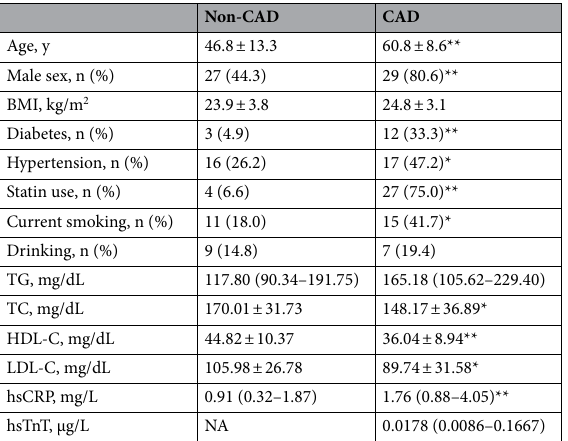
Table 1. Baseline characteristics of the non-CAD (n = 61) group and the CAD (n = 36) group. CAD, coronary artery disease; BMI, body mass index; TG, triglycerides; TC, total cholesterol; LDL-C, low-density lipoprotein cholesterol; hsCRP, high-sensitivity C-reactive protein; hsTnT, high-sensitivity Troponin T; NA, not applicable. * p < 0.05, ** p < 0.01.